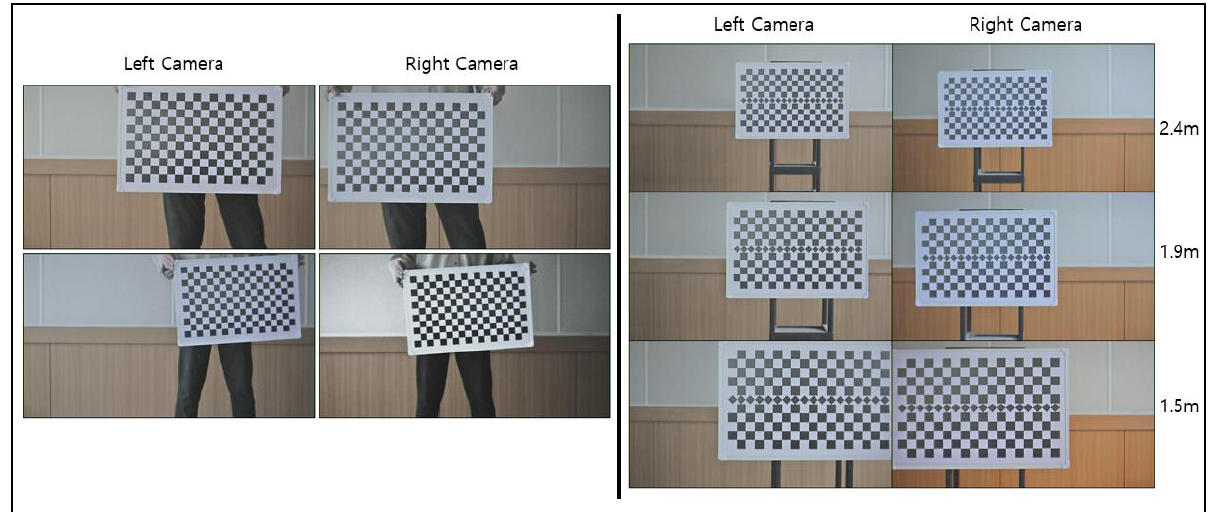
Figure 13. Stereo camera calibration using Zhang’s algorithm ( left ), and stereo camera calibration using the proposed calibration board ( right ).